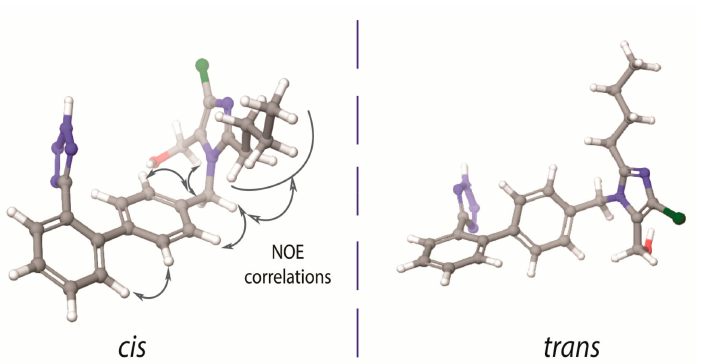
Figure 1. Cis and trans conformers of losartan. The nuclear Overhauser effect (NOE) between the two aromatic rings depicts absence of their orthogonality. ( left ) The imidazole ring and the tetrazole ring are placed in the same side of the molecule, with respect to the biphenyl ring spacer. ( right ) The imidazole ring and the tetrazole ring are placed in the opposite side of the molecule, with respect to the biphenyl ring